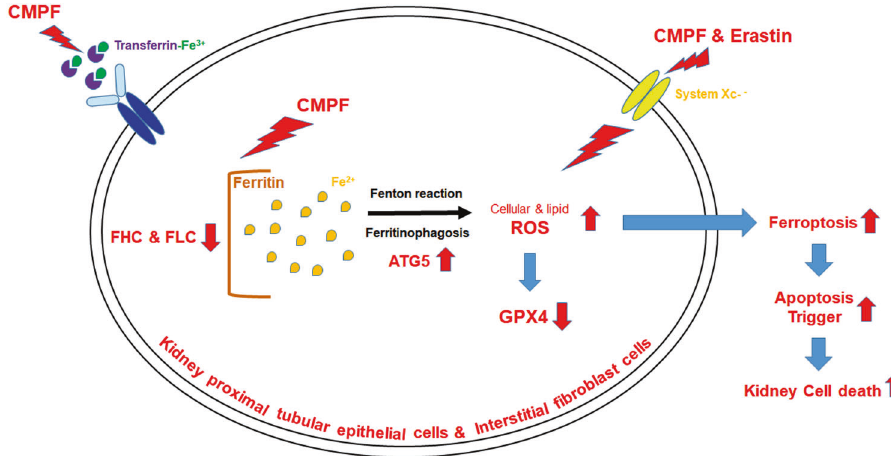
Fig. 9 Schematic diagram of ferroptosis regulation by uremic toxin CMPF. BUO mouse model and CMPF-treated HK-2 and NRK49F cells exhibit increased levels of iron accumulation, lipid peroxidation, and ferroptosis, accompanied by decreased levels of GPX4 expression, suggesting that CMPF induces ferroptosis and acts as a trigger of